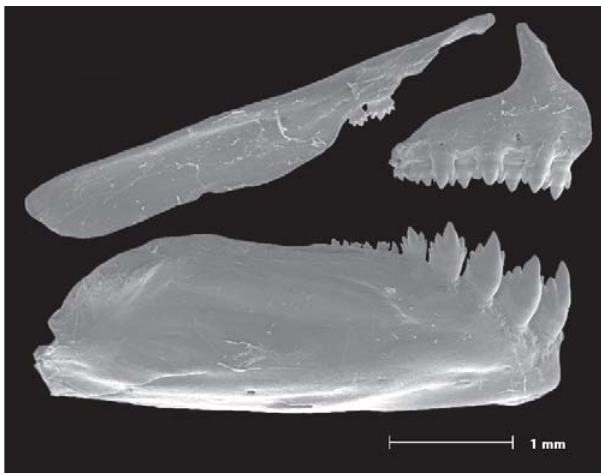
Fig. 2. Hyphessobrycon melanostichos , MCP 38396, paratype, 37.3 mm SL. Scanning electron microscope photograph of right side upper and lower jaws.